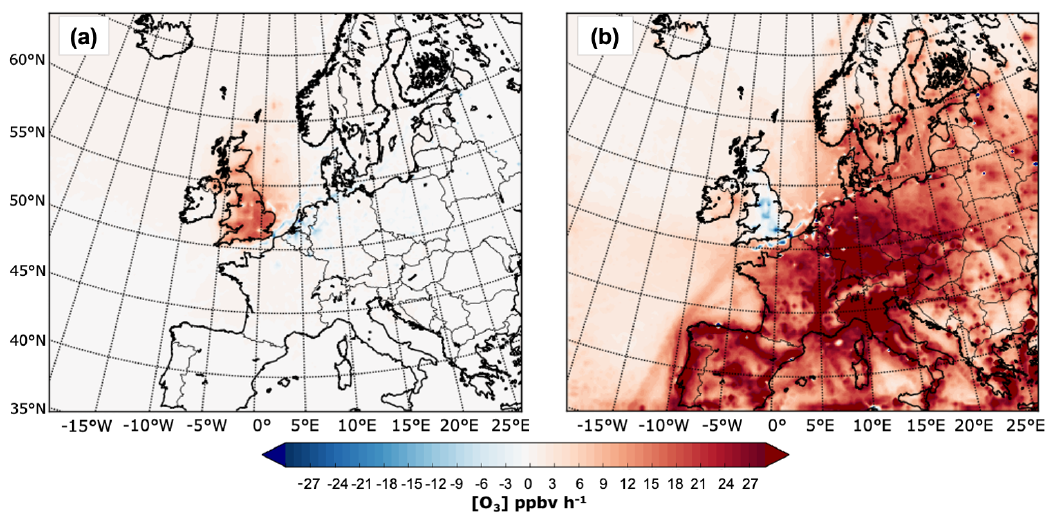
Figure 8. Net midday (11:00–14:00UTC) surface chemical production rate in ppbvh − 1 in July 2015 for O 3 from the UK (a) and European anthropogenic NO x emissions (b)